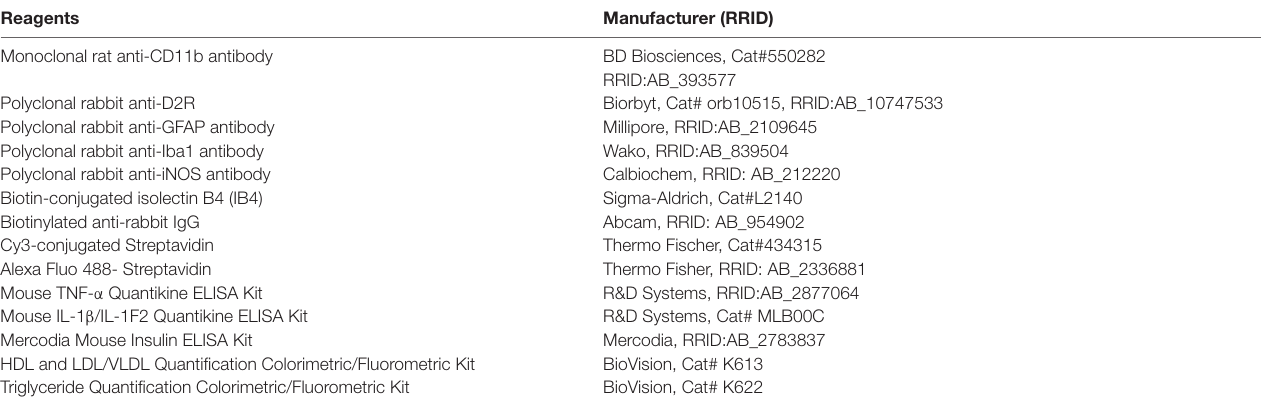
TABLE 1 | List of reagents (antibodies and assay kits) in the study.